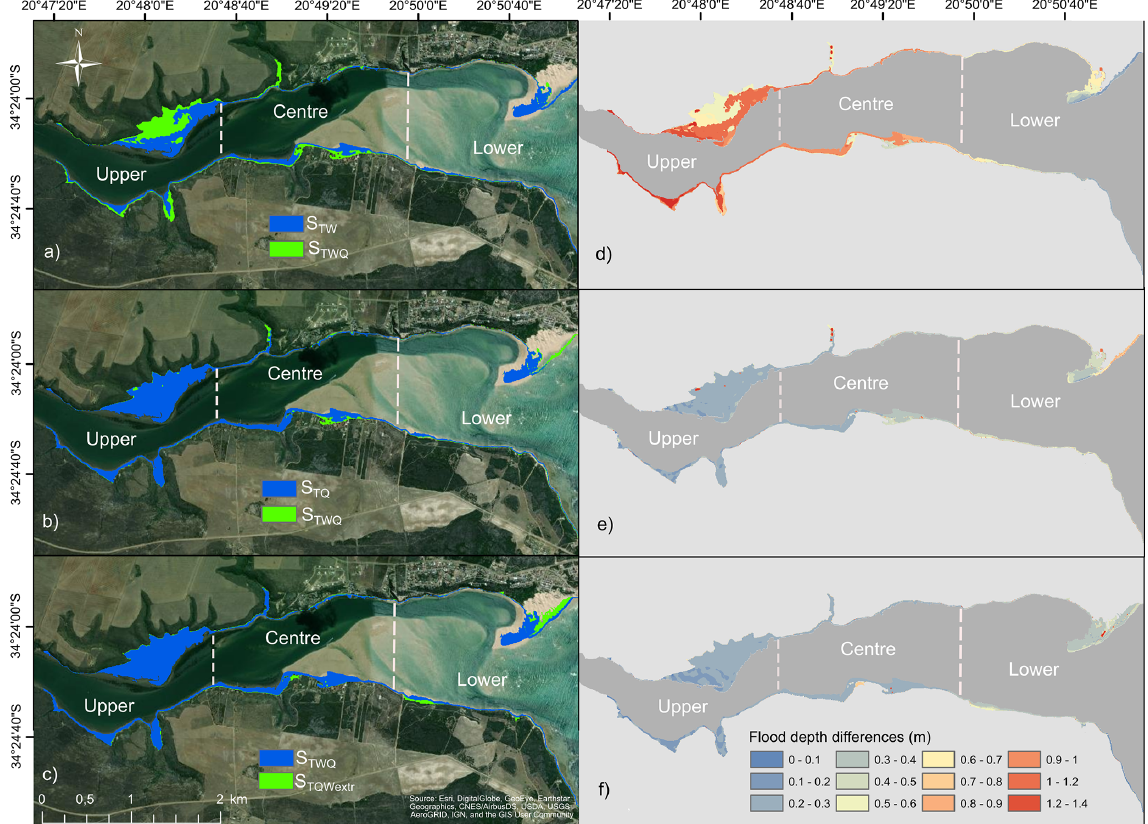
Figure 5. Comparison of flood extents of compound scenario and that excluding the driver (a–c) and differences in flood depths (d–f) . Panel (d) shows the flood depths of S TWQ -S TW , (e) shows S TWQ -S TQ , and (f) shows S TQWextr -S TWQ